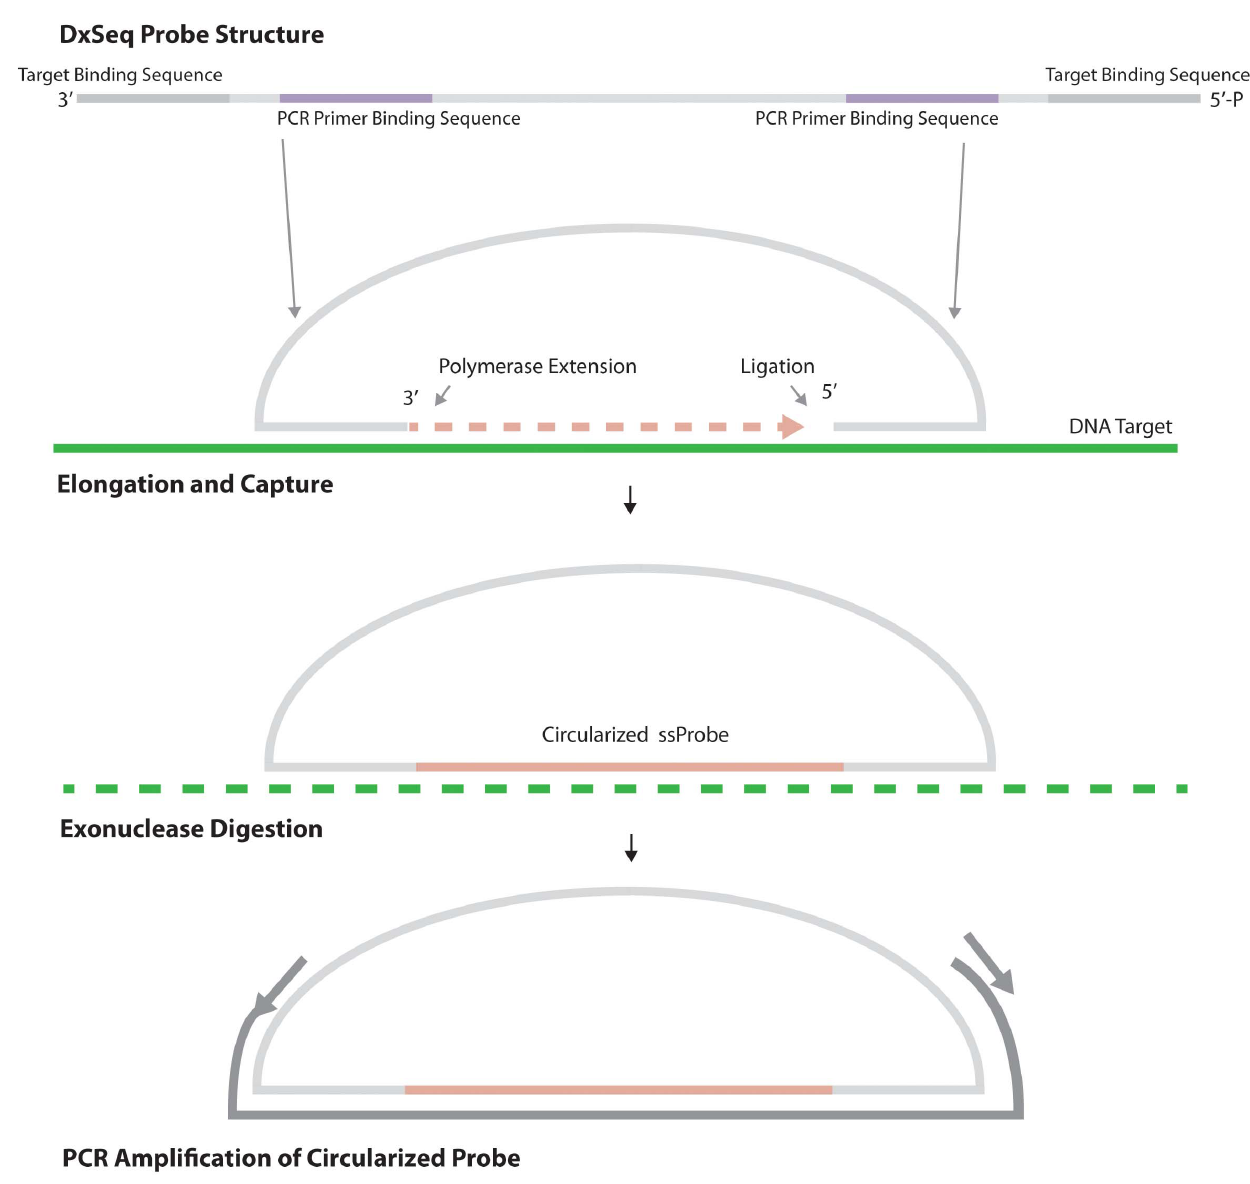
Figure 1. Overview of the DxSeq technology. Linear oligonucleotide probes contain complementary sequences that hybridize to the targeted sequence. A polymerase fills in the target sequence, and a ligation reaction captures the sequence within the circularized probe (Circularized ssProbe). Exonucleases remove noncircularized probe and DNA within the reaction, and the captured sequence is amplified by PCR using primers within the probe that bridge the captured